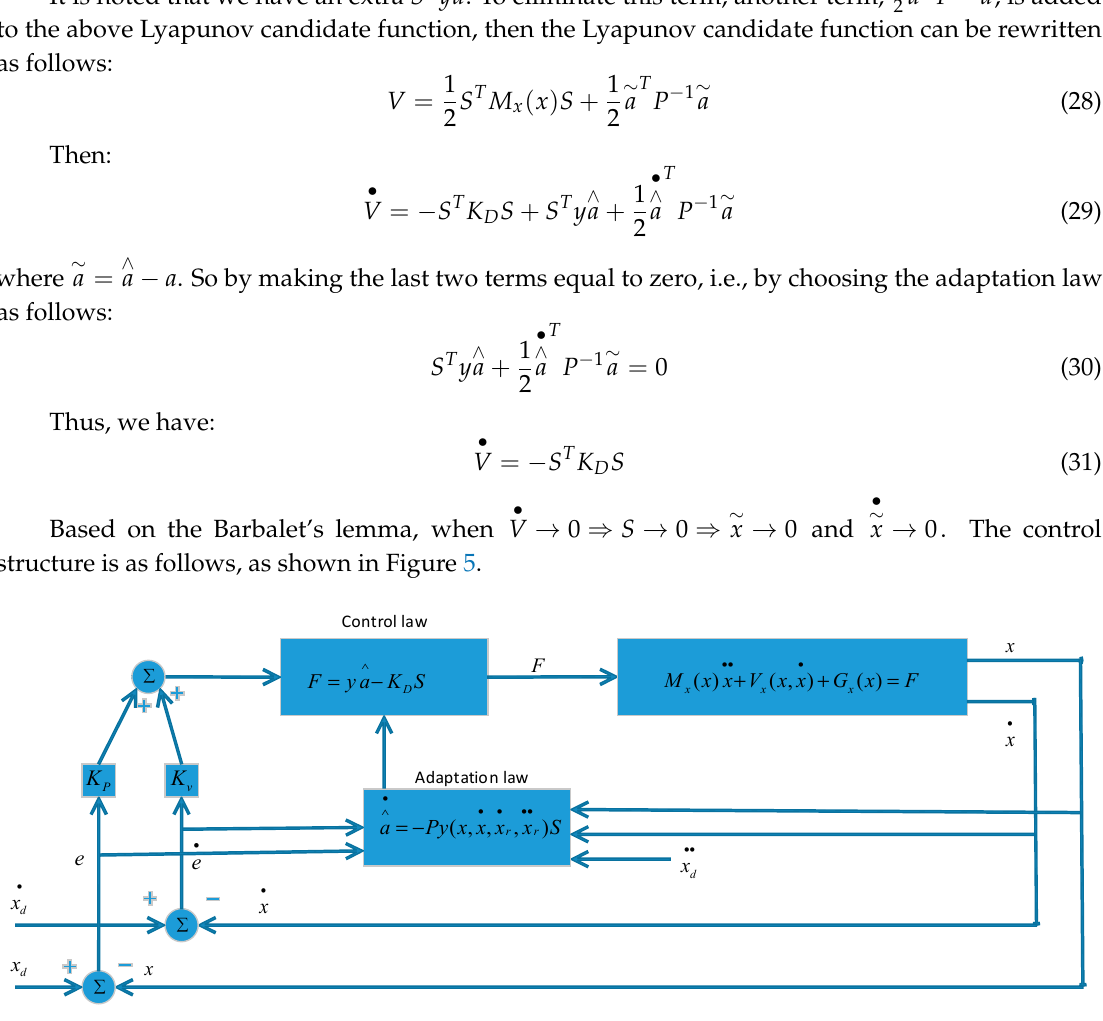
Figure 5. Adaptive control structure.